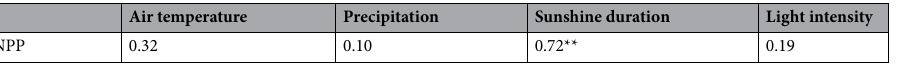
Table 3. Correlation coefficients between NPP and air temperature, precipitation, sunshine duration, and light intensity. **A highly significant